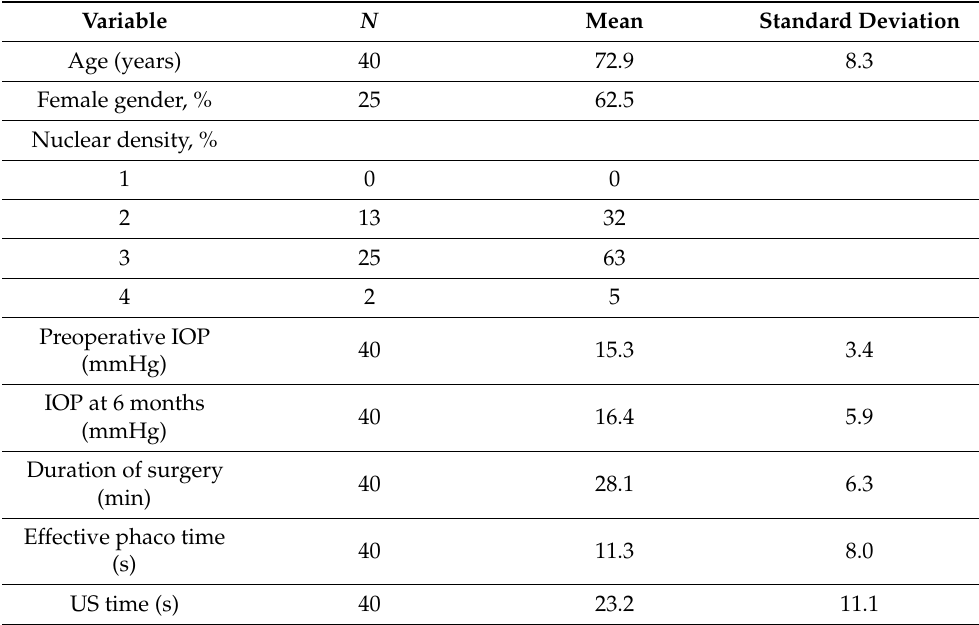
Table 1. Baseline demographics and characteristics of the study group ( N = 40).